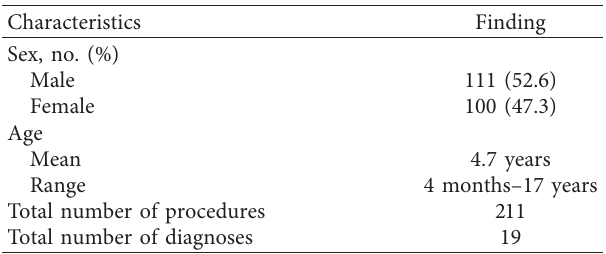
Table 2: Patient